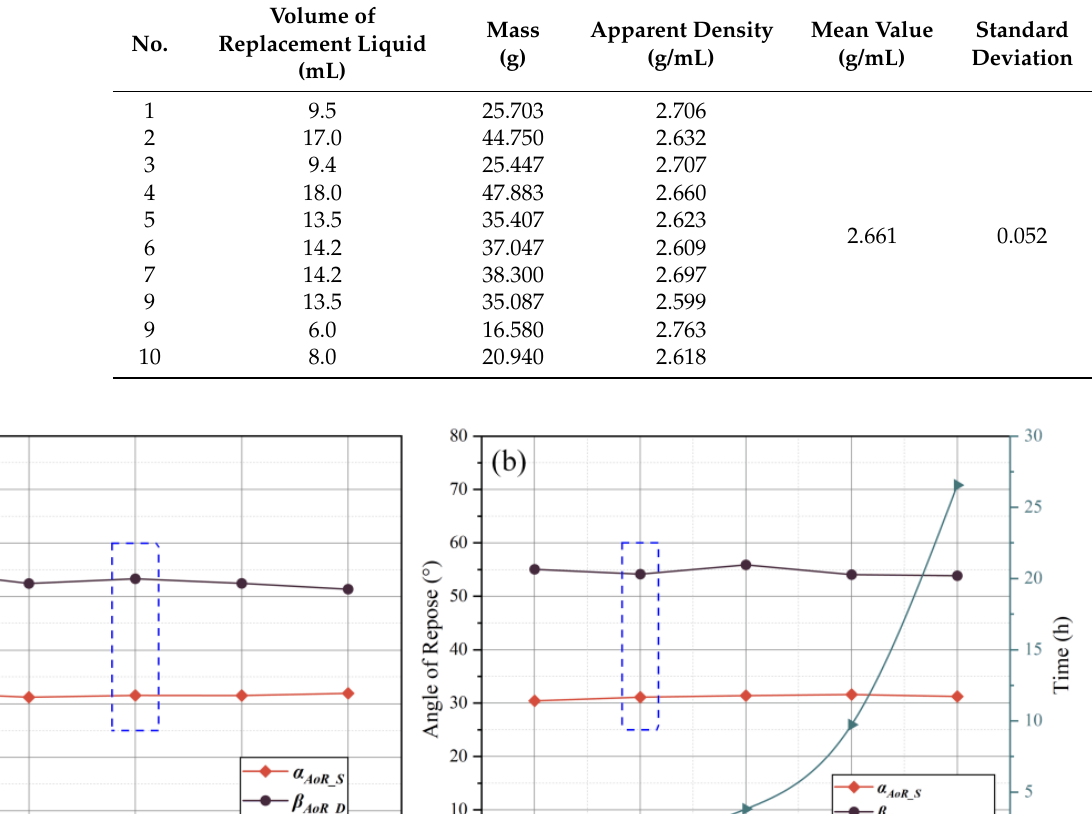
Table 5. Apparent density measurement of particles.